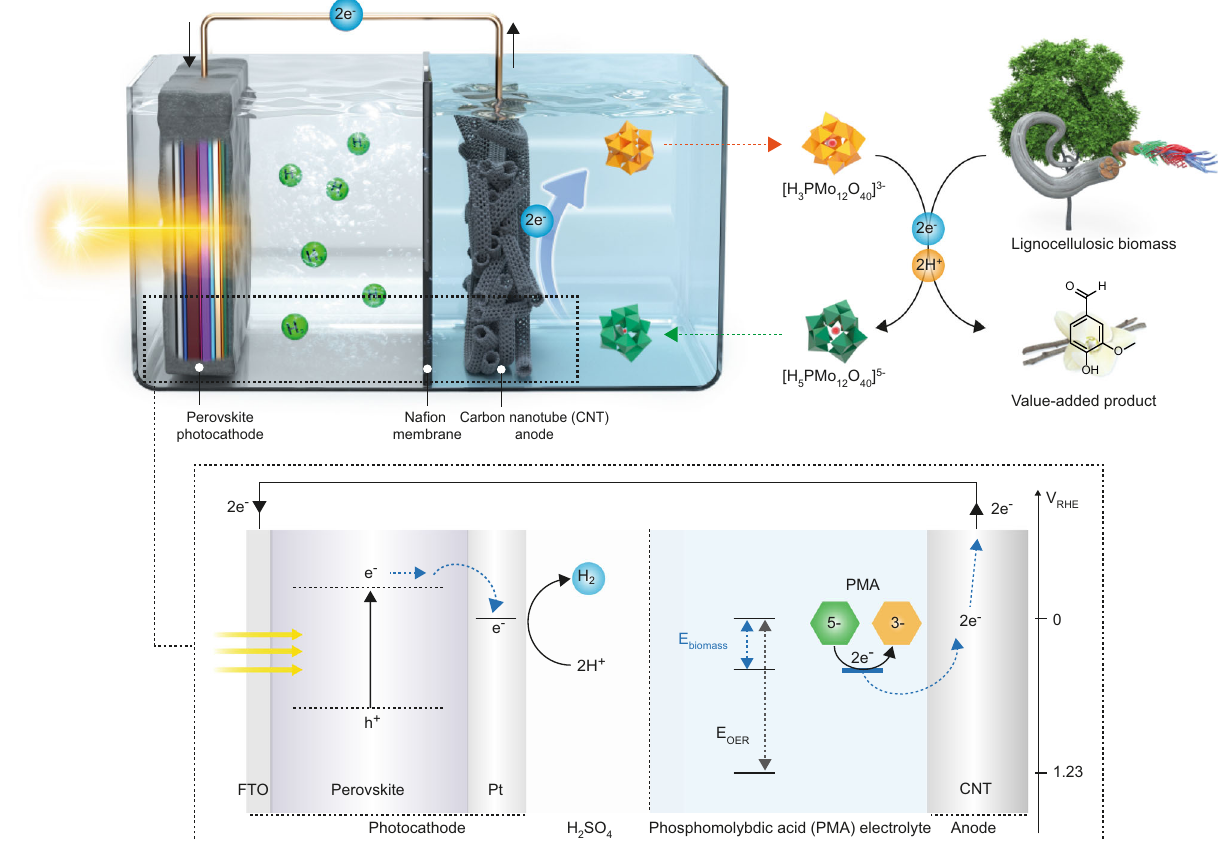
Fig. 1 | Schematic illustration of biomass – PEC system for unassisted solar hydrogen evolution. Perovskite photocathode with Pt catalyst and electron extraction system from biomass are combined for bias-free hydrogen evolution.